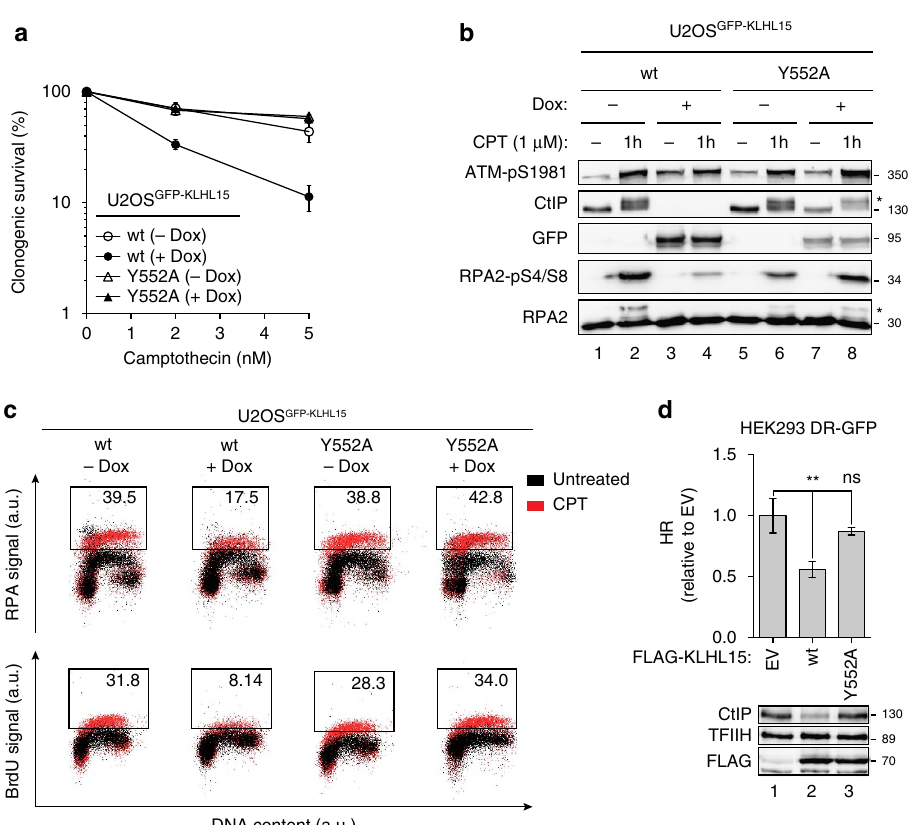
Figure 4 | KLHL15 overexpression leads to camptothecin hypersensitivity and defective DNA-end resection. ( a ) U2OS Flp-In T-REx cells inducibly expressing GFP-KLHL15-wt or GFP-KLHL15-Y552A were cultivated in the presence or absence of Dox. Twenty-four hours post induction, cells were treated with the indicated doses of camptothecin and survival was determined after 10 days by colony-formation assay. Data are presented as the mean ± s.d. ( n ¼ 3). ( b ) Same cells as in a were mock-treated or treated with camptothecin (CPT, 1 m M) for 1h and lysates were analysed by immunoblotting using the indicated antibodies. Asterisks indicate hyperphosphorylated forms of CtIP and RPA2, respectively. ( c ) Same cells as in b were labelled with BrdU (30 m M) for 24h before CPT treatment. Cells were harvested, permeabilized, fixed, immunostained with anti-RPA2 or anti-BrdU antibody and analysed by FACS. Dot plots representing the intensity of the signals for RPA2 or BrdU staining ( y axis) against the DNA content ( x axis). Quantification gates were established in untreated samples and the percentage of cells within the gates is indicated. ( d ) HEK293 DR-GFP cells were transfected with the I-SceI in combination with the indicated FLAG-KLHL15 expression plasmids and harvested after 48h for flow cytometry and immunoblot analysis. Data are represented as mean ± s.d. ( n ¼ 3). Statistical analysis were carried out using unpaired, two-tailed t -tests. P values expressed as ** ( P o 0.005) were considered significant. A.u., arbitrary units; FACS, fluorescence-activated cell